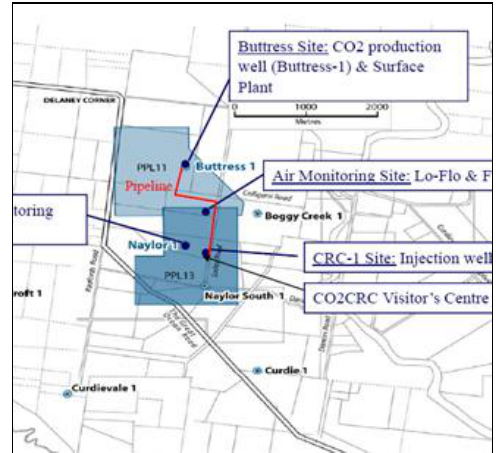
Figure 1. Otway CO2CRC Sequestration project,